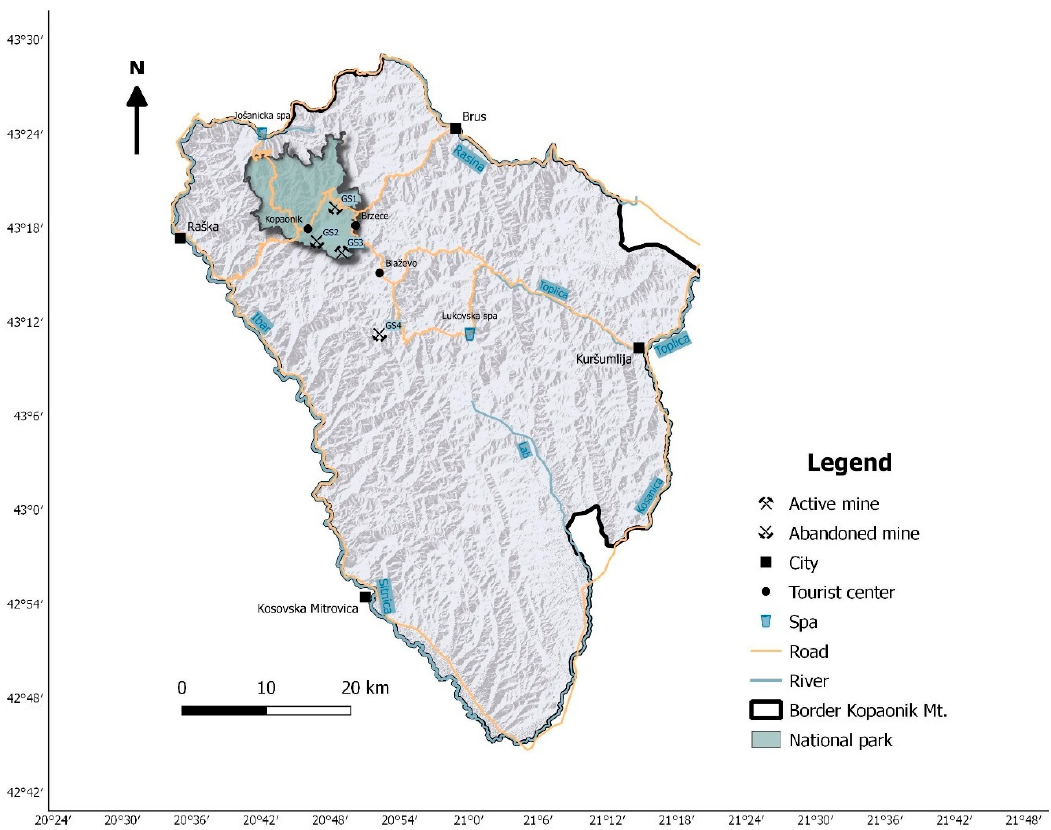
Figure 1. Location map of Kopaonik Mountain.